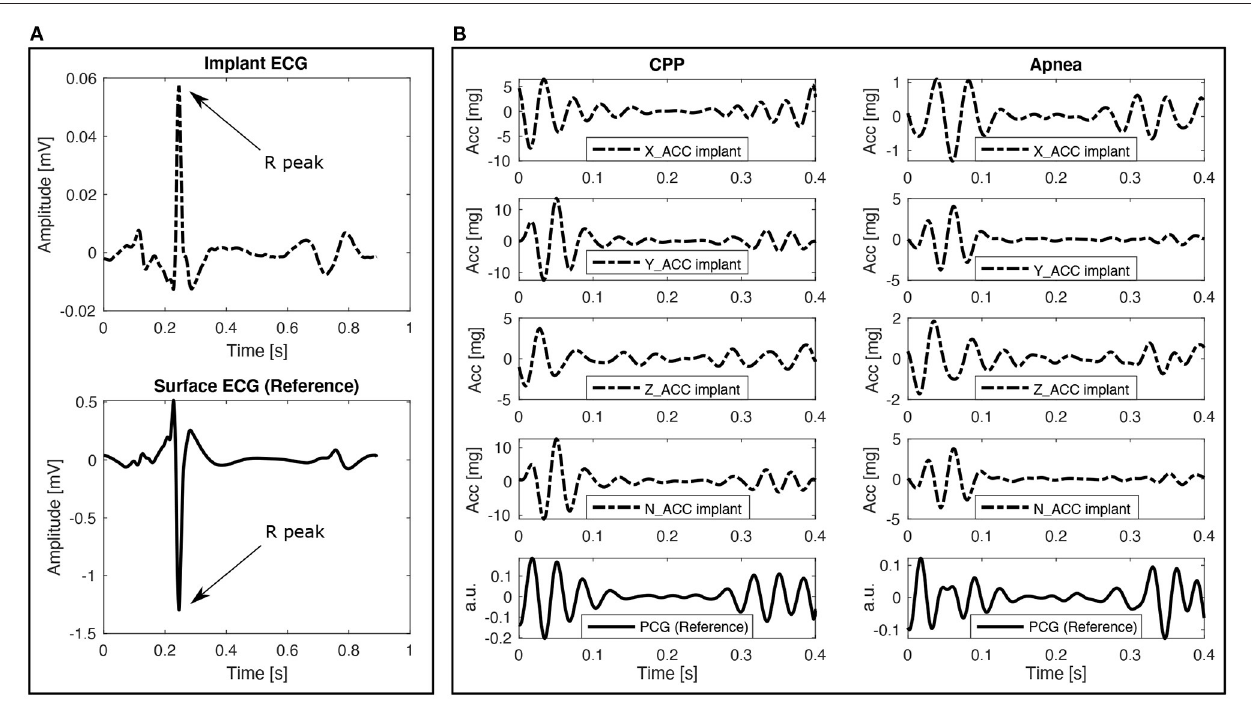
FIGURE 6 | Example of implant and gold standard signals comparison. Dash-dotted lines correspond to the implant signals and solid lines correspond to the gold standard reference signals. (A) Coherent mean cycles of ECG signals taken from one representative recording. Note that the differences in signal morphology and amplitude between the surface and gastric devices are mainly explained by the significantly different dipoles that are observed. (B) Coherent mean cycles of ACC and PCG signals during both respiratory phases taken from the recording 2.